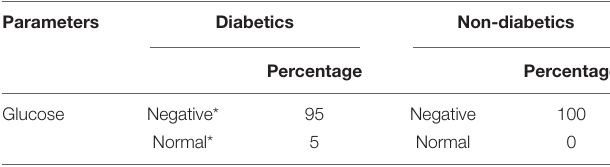
TABLE 3 | Salivary glucose percentage in children with type 1 diabetes mellitus and healthy children.